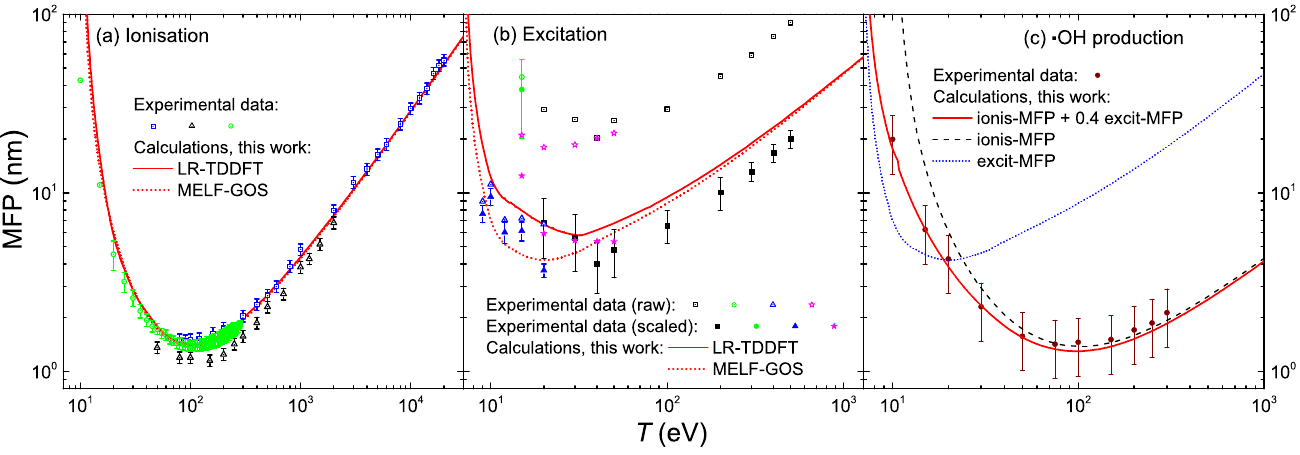
Figure 8. ( a ) Ionisation mean free path (ions-MFP) of electrons in water, as a function of the incident energy T . Red solid (dotted) lines are calculations using the LR-TDDFT (MELF-GOS) model for liquid water. Symbols are experimental data for water vapour [129] (blue squares), [128] (black triangles) and [130] (green circles). ( b ) Excitation mean free path (excit-MFP) of electrons in water, as a function of the incident energy T . Red solid (dotted) lines are calculations using the LR-TDDFT (MELF-GOS) model for liquid water. Symbols are experimental data for water vapour [131] (black squares), [132] (green circles), [133] (blue triangles) and [134] (magenta starts); empty and full symbols represent raw and scaled experimental data, respectively, as explained in the text. ( c ) Mean free path for the production of · OH radicals as a function of the incident energy T . The red solid line represents a weighting of ionisations and excitations, as explained in the text, based on the MELF-GOS model for liquid water; symbols are experimental data for water vapour